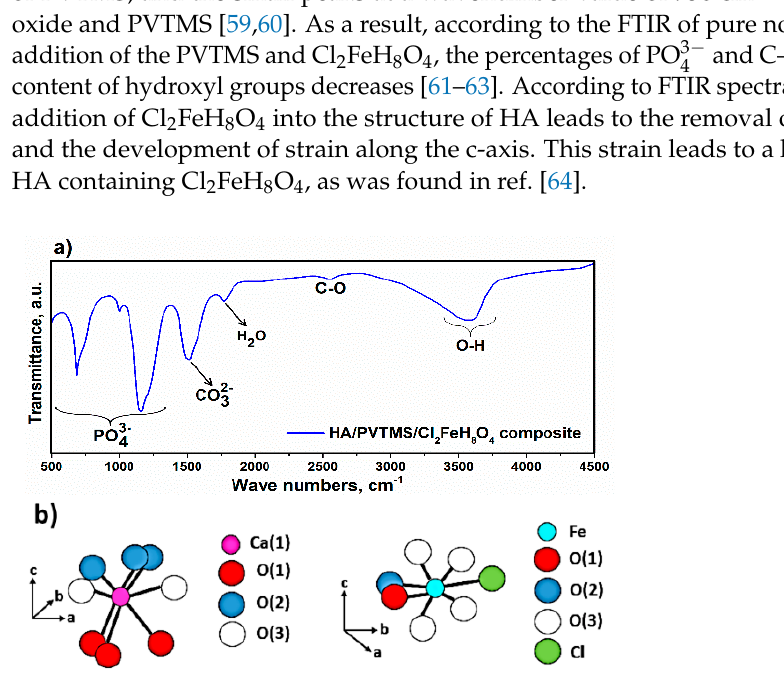
Figure 5. ( a ) FTIR spectrum of composite and ( b ) schematic of Fe and Cl substitution in the composite.